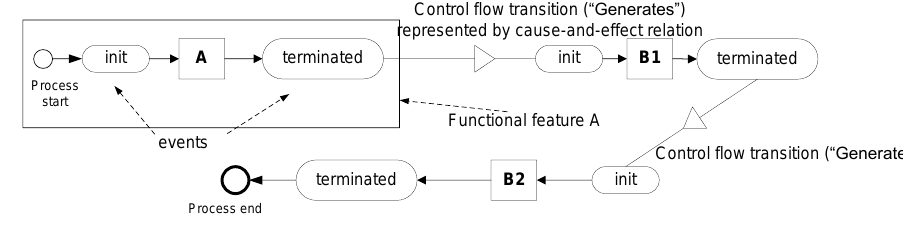
Fig. 5. The initiation and conduction of FF.